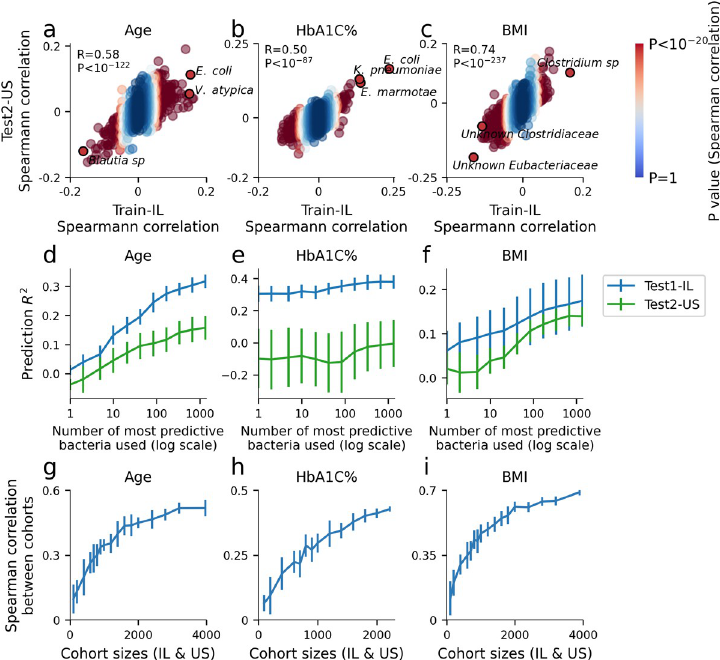
Fig 5. Correlations of single species with age, HbA1C% and BMI. (a) Spearman correlation of each bacterial species with age in the Israeli training cohort (x-axis, N = 27,075) and the U.S. test cohort (y-axis, N = 3,974). The correlation and P-value between the correlation coefficients of each cohort are shown. Bacteria are colored according to the P- values of the Spearman correlation coefficient in the Israeli cohort. The top three bacteria by Israeli P-values that replicate in the U.S. cohort are highlighted. (b)-(c) Same as (a) for HbA1C% and BMI. (d) R 2 of predictions on Test1-IL and Test2-US cohort, using a partial set of bacteria features for XGBoost. X-axis represents the number of bacteria (with the highest Spearman correlation to phenotype, on the Train-IL cohort) used to build the model. (e)-(f) Same as (d) for HbA1C% and BMI. (g) Spearman correlation between the correlation coefficients of the Israeli cohort and U.S. cohort as in (a) but for different sub-samples of cohort sizes. For each cohort size k , a sub-sample of k individuals was obtained from both the Israeli and U.S. cohorts and this procedure was repeated 10 times to obtain standard deviation error bars. (h)-(i) Same as (g) for HbA1C% and